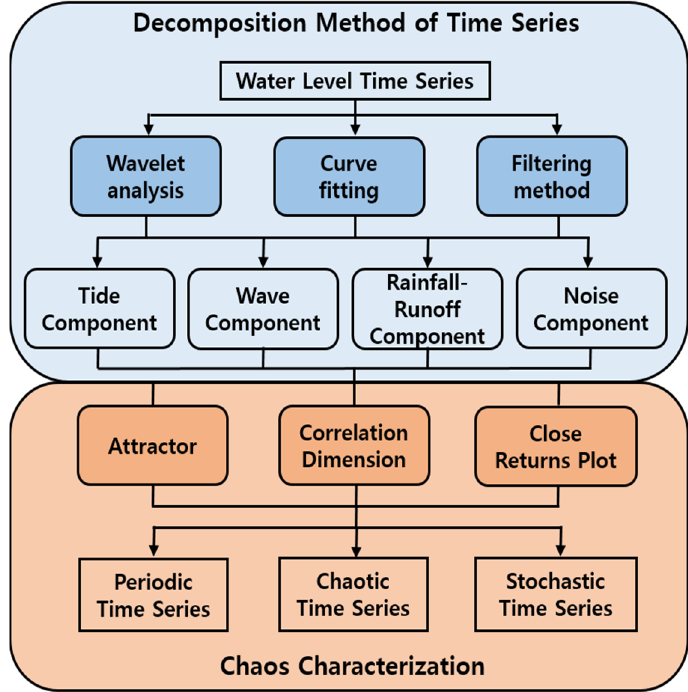
Figure 1. Flowchart and analysis method of the study.